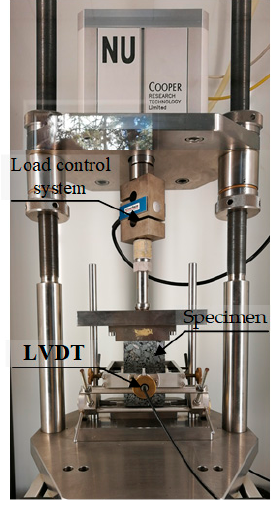
Figure 5. Indirect tensile stiffness modulus (ITSM) test used in this paper.